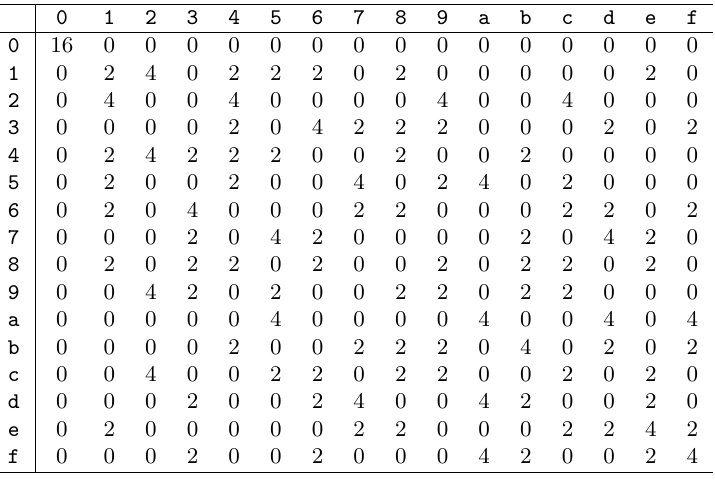
Table 4: The differential distribution table of the CRAFT S-box